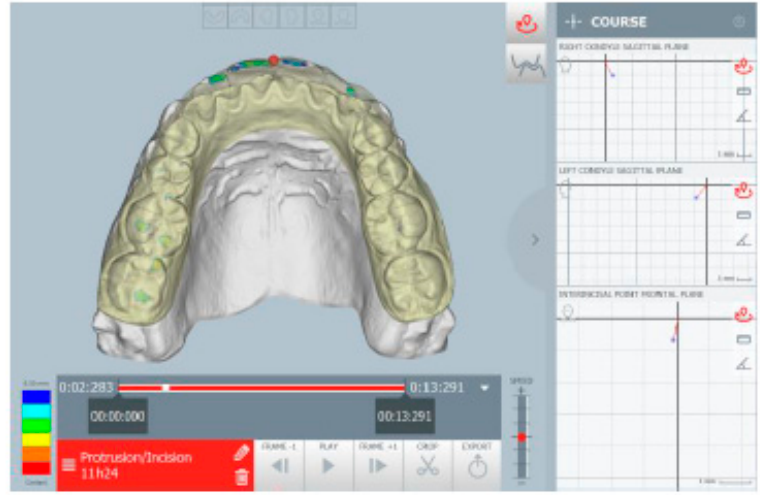
Figure 18. The protrusion tracing.